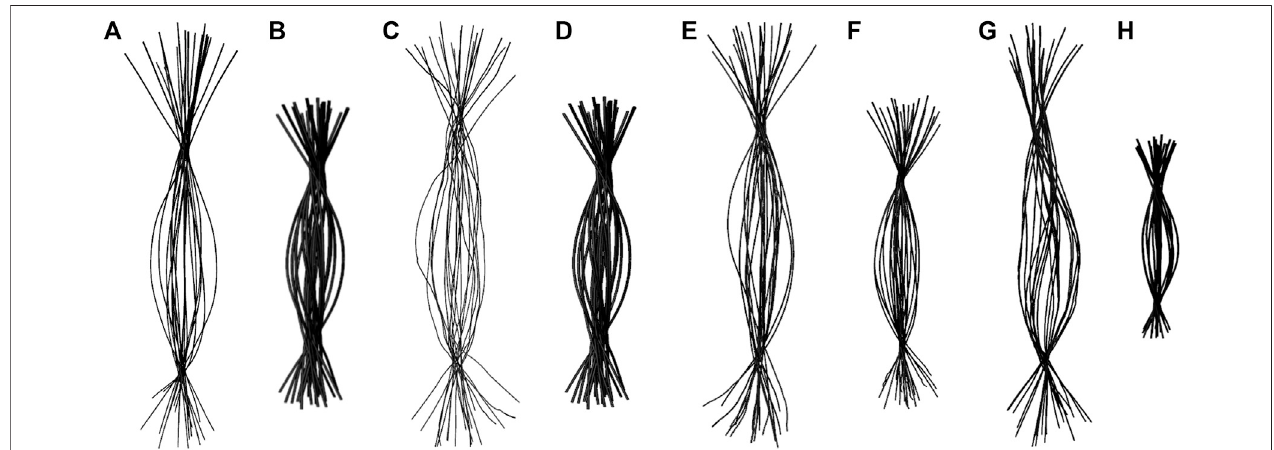
FIGURE 8 | Overlay of the curvilinear helical axis in 20×CUG (A) , 10×CUG (B) , 20×CAG (C) , 10×CAG (D) , 15×CCUG (E) , 10×CCUG (F) , 10×AUUCU (G) , and 4×AUUCU (H) . Curvilinear axis was measured for each average structure of the 20 clusters, and overlayed to provide a visual inspection of the degree of bending observed in each system.